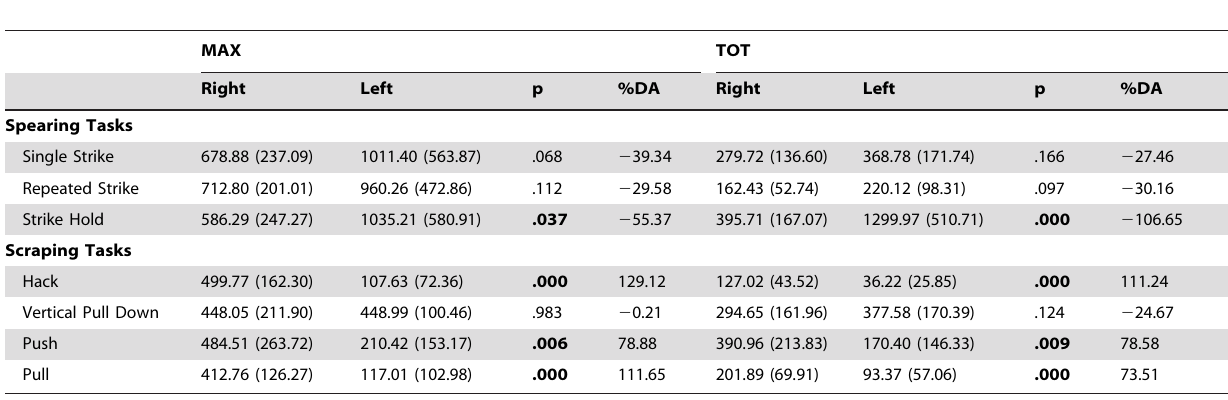
Table 1. Bilateral anterior deltoid maximum (MAX) and total (TOT) muscle activity for all scraping and spearing tasks.